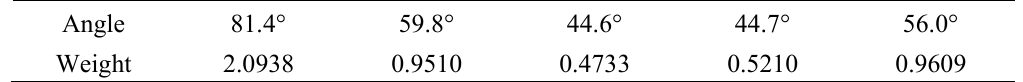
Table 7. Weight of each angle image for the RESW method in the real image data experiment.